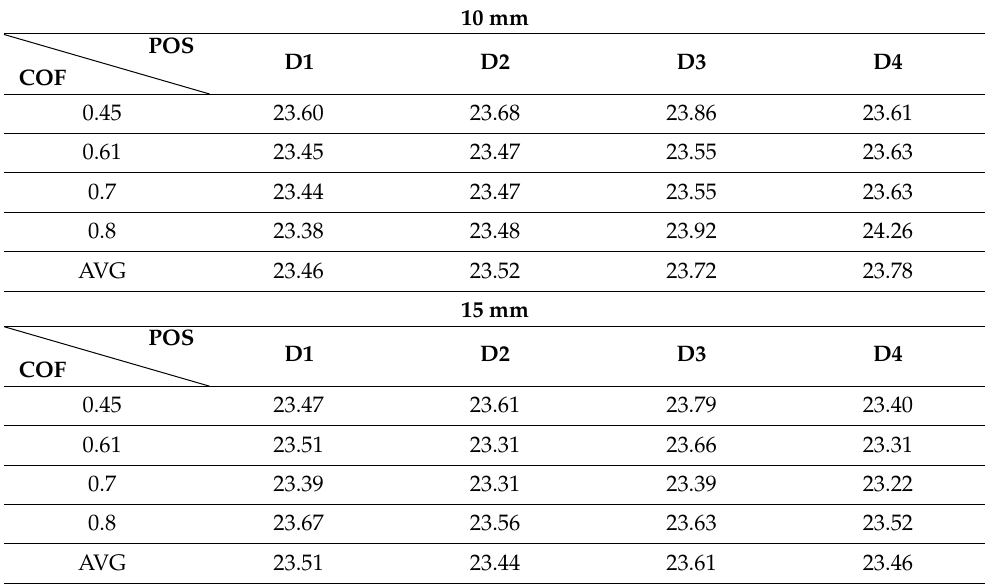
Table 7. Hoop deformation results with hub thicknesses of 10 and 15 mm in method